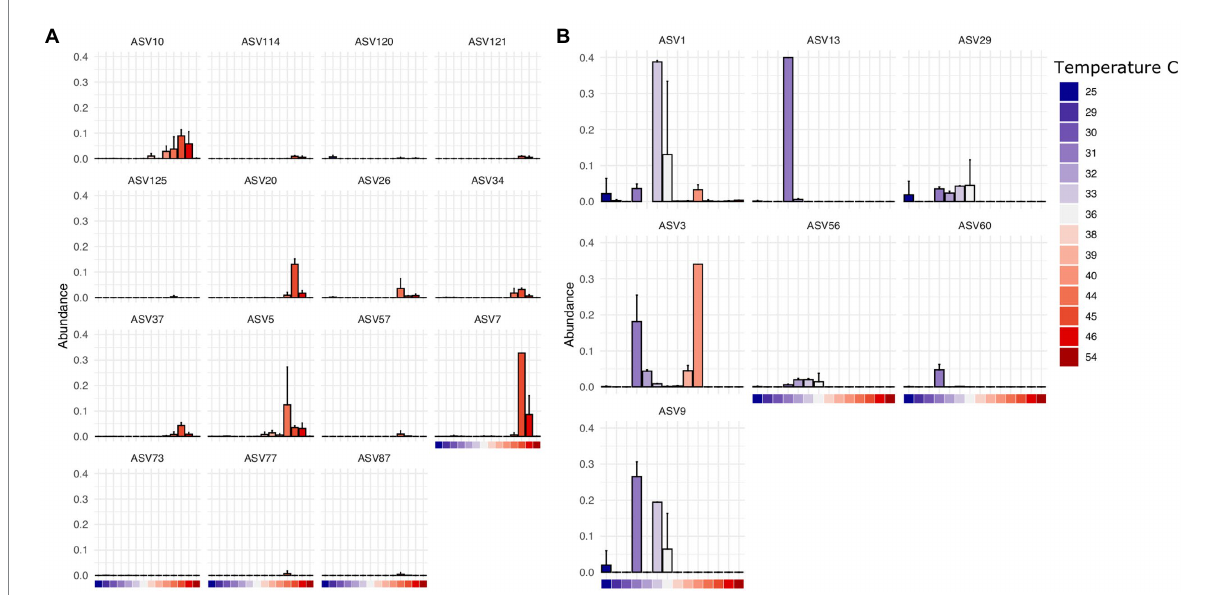
FIGURE 5 Thermally restricted ASVs in two genera. (A) Average relative abundance and standard deviation of the most abundant ASVs assigned to Clostridium by temperature at the site of sampling. (B) Average relative abundance and standard deviation of the most abundant ASVs assigned to Ignatzschineria by temperature at the site of